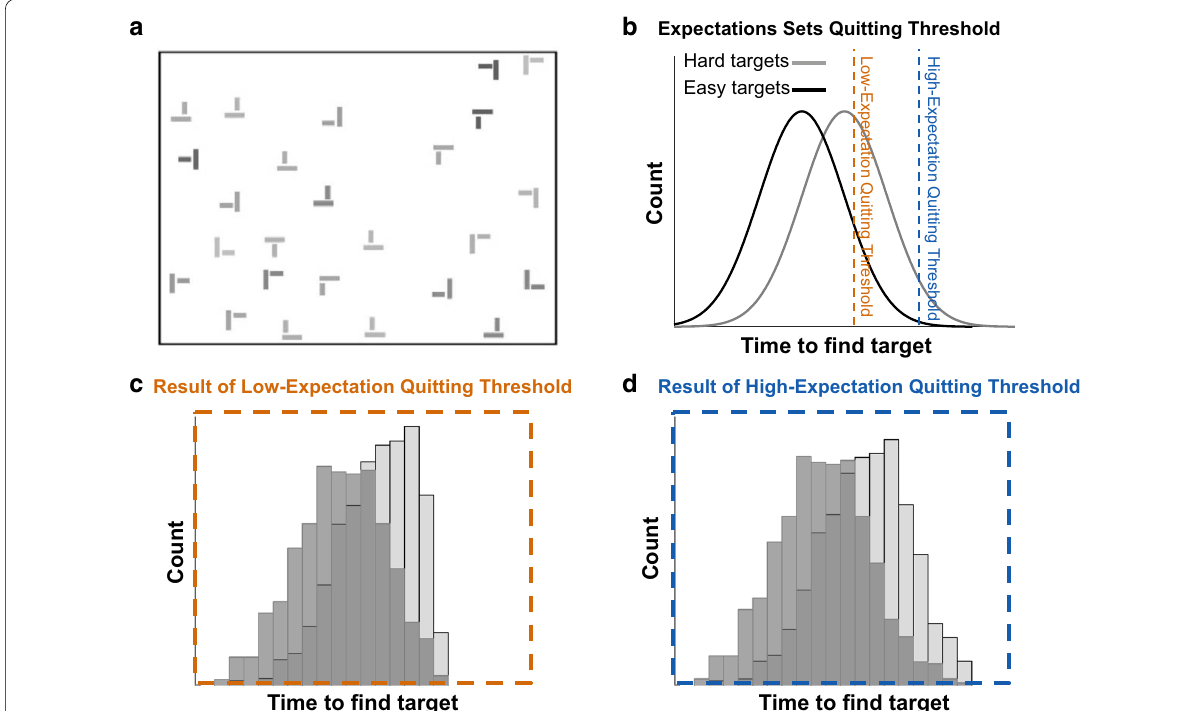
Fig. 1 Example stimuli and theoretical model illustrating the predicted results. a Example dual-target display. The easy target (dark gray rotated T) is located in the upper left quadrant and the hard target (light gray T) is located in the lower left. b Theoretical depiction of underlying difficulty distributions from which the “Hard” (light gray) and “Easy” (dark gray) targets for each trial were drawn from. More difficult-to-find targets fall farther to the right on the distribution and will take longer to find. The prediction is that expectations about the underlying trial structure differentially set the quitting threshold (low-expectation in orange, high-expectation in blue). c Hypothetical distribution of found targets for the low-expectation quitting threshold in panel B. d Hypothetical distribution of found targets for the high-expectation quitting threshold in panel B. Comparing panels C and D, illustrates the prediction that the higher quitting threshold leads to higher hit rates by allowing time for the searcher to find the more difficult targets from the far right of the distribution in panel B. In turn, the mean response time for finding a target increases with the higher quitting threshold, particularly for the hard